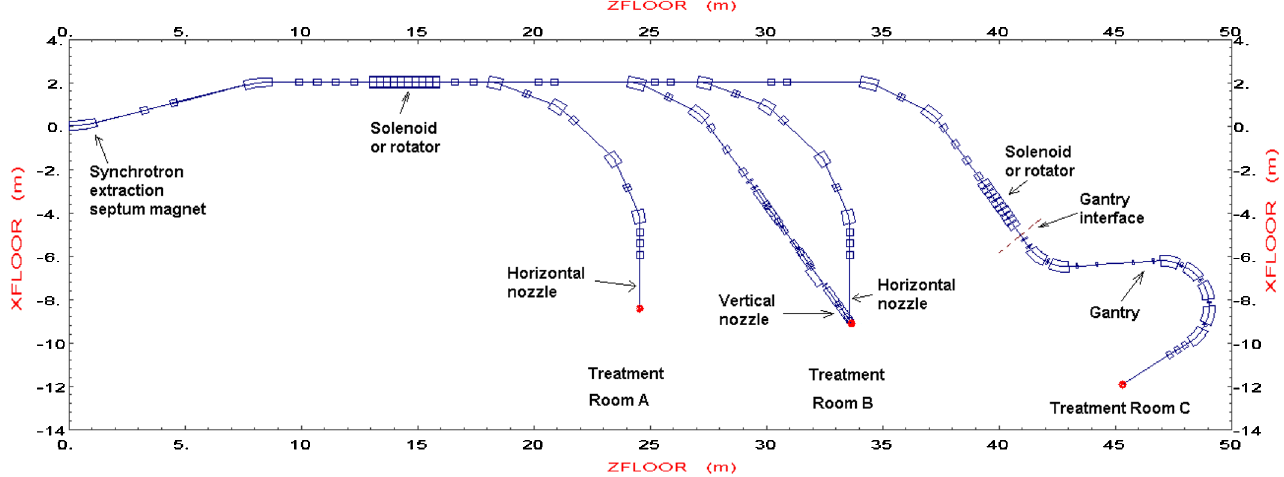
FIG. 6. (Color) An example of beam transport and delivery system for proton therapy using the emittance balancing